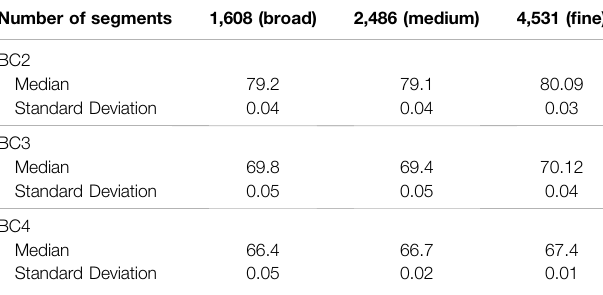
TABLE 4 | Overall mean and standard deviations for the three segment sizes